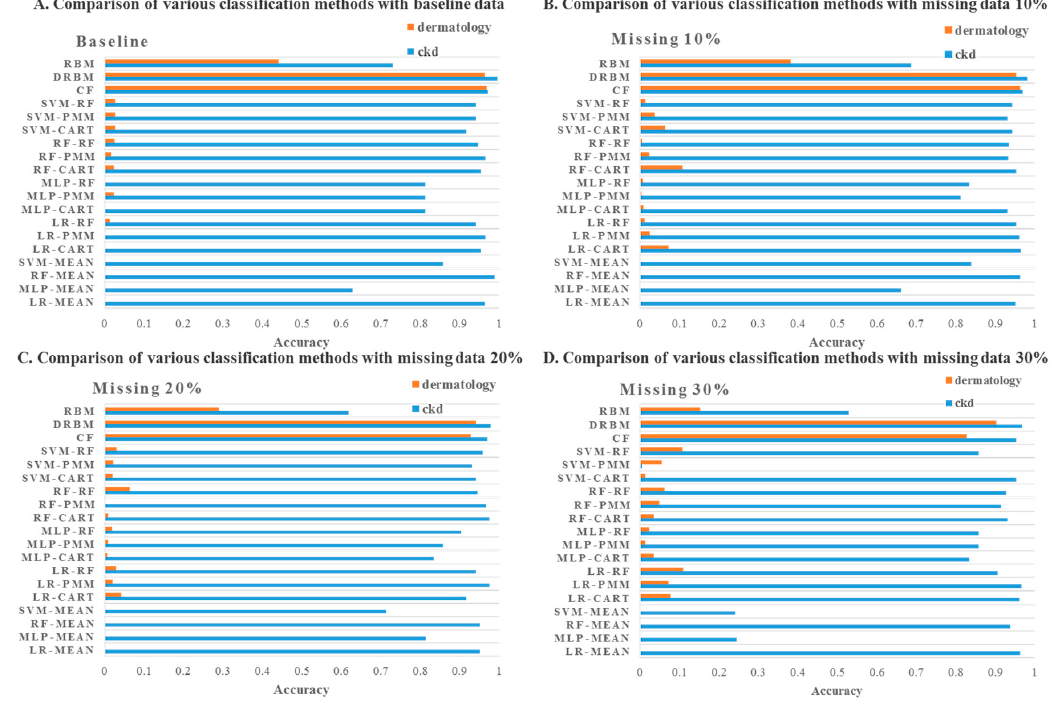
Figure 8. Comparison of traditional machine-learning classification methods with baseline data and various level of missing data.